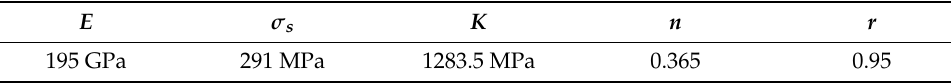
Table 2. Mechanical properties parameters of SUS